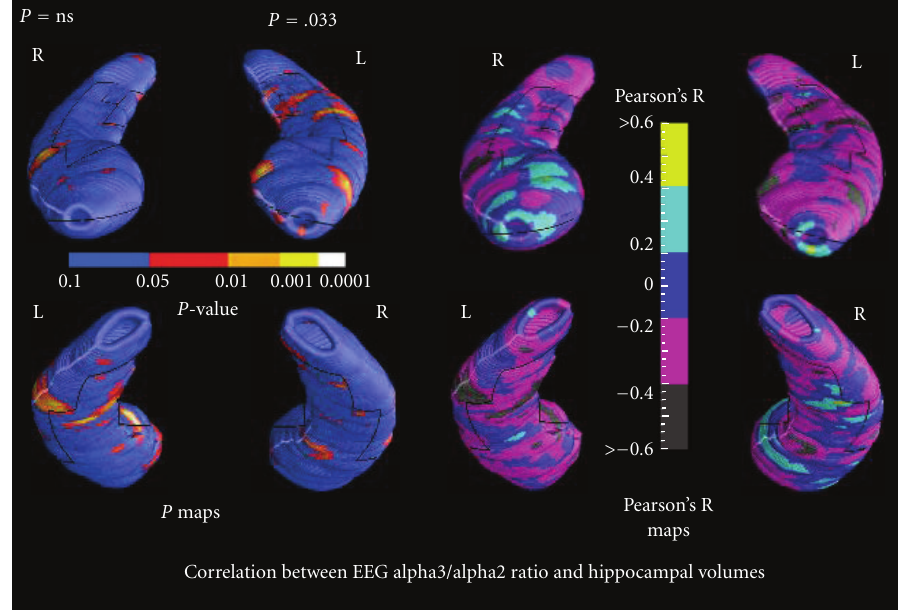
Figure 3: Correlation between alpha3/alpha2 power rhythm ratio and volumes of hippocampal subregions in AD patients. Permutations overall P values are displayed on top of each